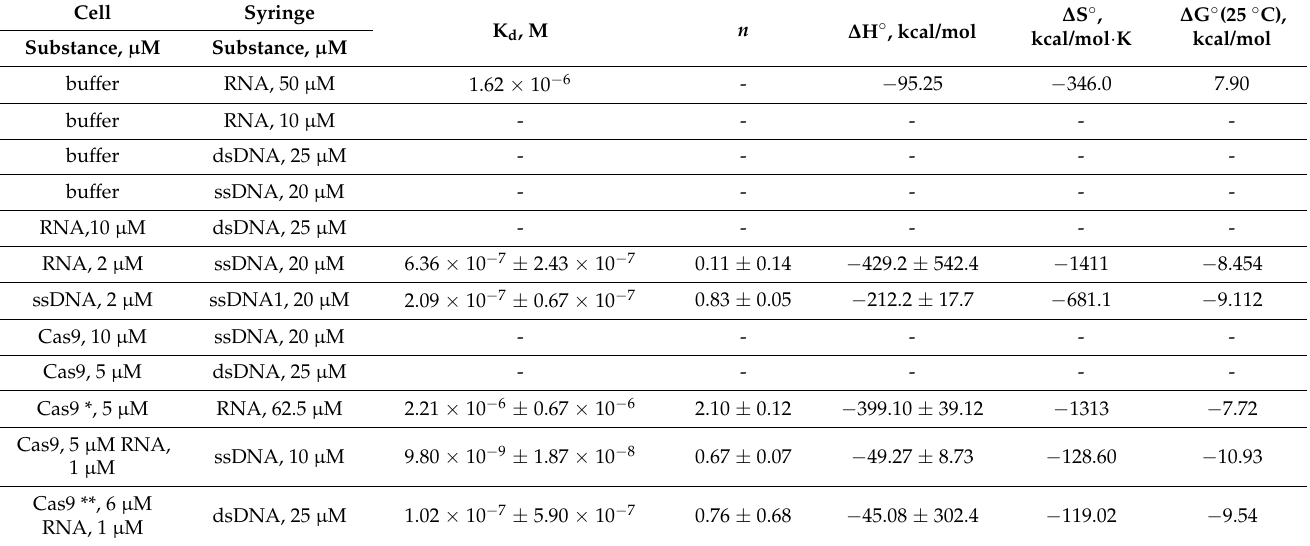
Table 1. The thermodynamic parameters obtained by